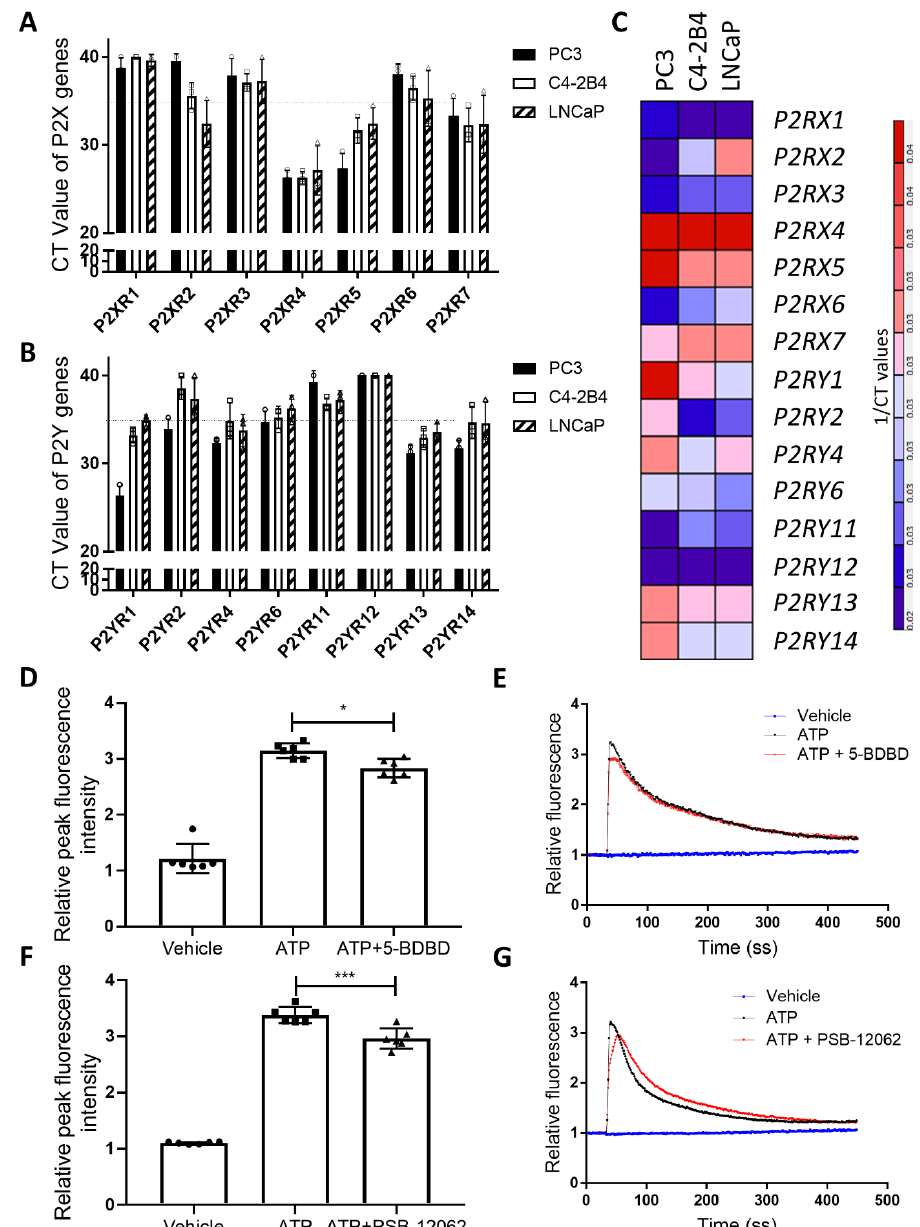
Figure 1. P2X4R is functionally expressed in PCa cell lines. Total mRNAs were isolated from three human PCa cell lines: PC3, LNCaP, and C4-2B4 cells. Individual quantitative RT-PCRs were performed to reveal the gene expression profile of ( A ) P2X and ( B ) P2Y receptors in these PCa cells. CT values < 35 were regarded as the transcription expression of P2X and P2Y receptors. ( C ) A heatmap showing the gene expression pattern variance was built from reciprocals of CT values, using the ‘GenePattern’ web software. Colour scale = 1/CT values. To understand whether P2X4R was functional, PC3 cells were pretreated with P2X4R specific antagonists, and then 50 μM ATP (to maximally activate P2X4R but not P2X7R)-induced calcium influx was examined using the Fluo-4 Direct™ agent. All data were normalized to both the baseline and ionomycin-induced full calcium influx. The peak fluorescence intensity was compared among the vehicle, ATP, and ATP plus ( D ) 1.0- μM 5-BDBD or ( F ) 1.5-μM PSB-12062. The representative ATP-induced calcium influx curve over a 450 s period with or without ( E ) 5-BDBD or ( G ) PSB-12062 antagonist pretreatments. Data are the mean ± SD, n = six biological repeats, one-way ANOVA with post hoc Tukey test, * p < 0.05, *** p < 0.001.